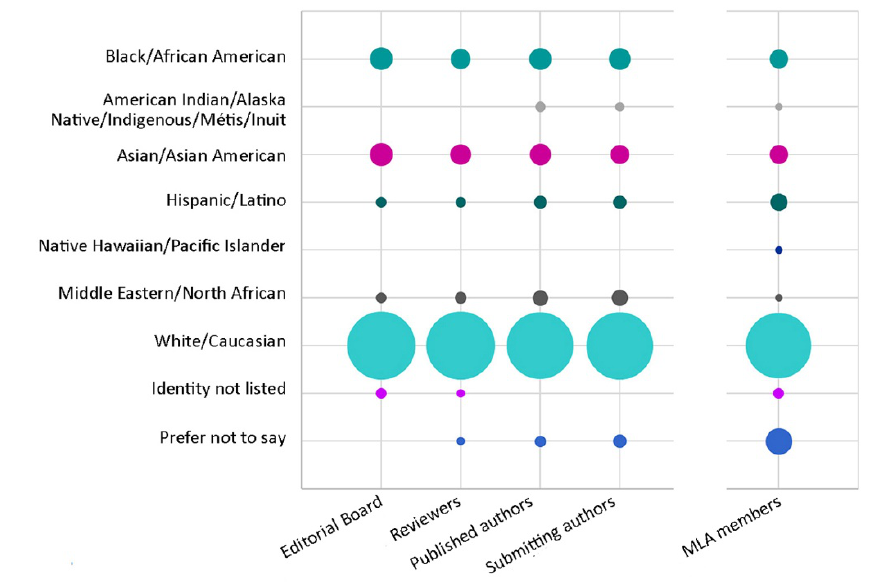
Figure 1 Racial identity of Journal of the Medical Library Association (JMLA) editorial board members, reviewers, and published and submitting authors (compared with MLA members [7])